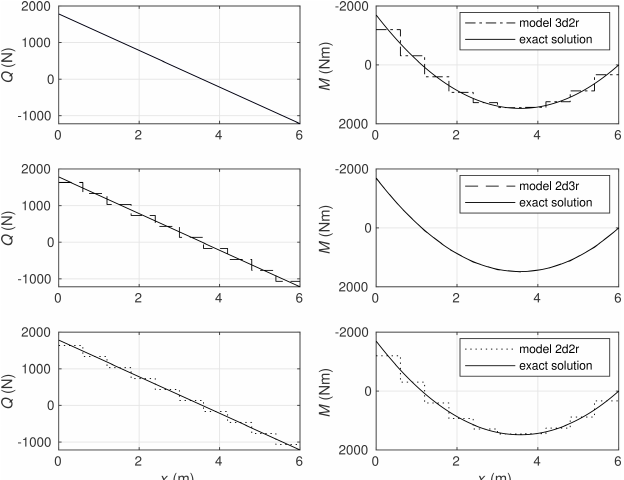
Figure 5. Comparison of section forces obtained by displacement-based models with the exact solution reproduced precisely by the equilibrium model.